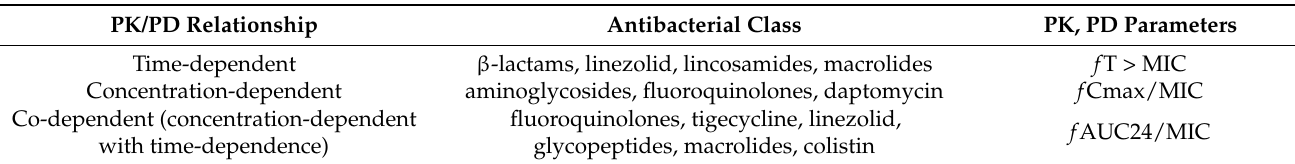
Table 1. PK/PD relationship of antibiotics